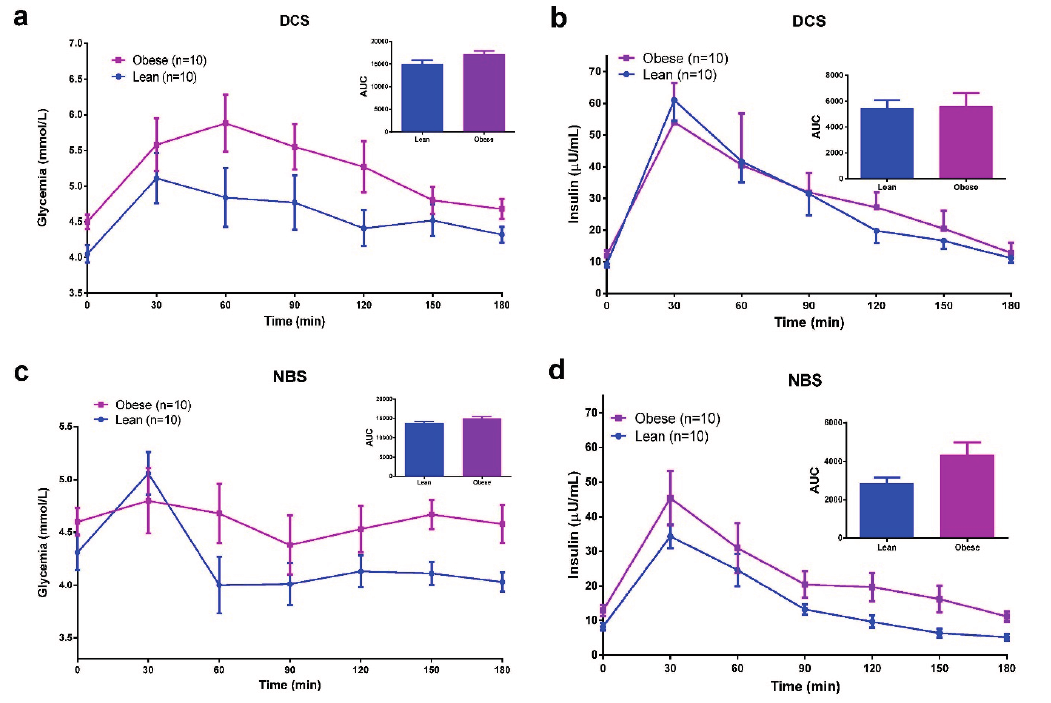
Figure 3. Differences between lean and obese subjects in glycemic and insulin responses during a Meal Tolerance Test (MTT) ( a , b ) Beverage containing digestible corn starch (DCS). ( c , d ) Beverage containing native banana starch (NBS). Notes: Beverages were administered 5 min before the standardized food. Areas under the curve (AUC) were compared using an unpaired Student t test. In ( a ) Obese vs. Lean p = 0.0853; in ( b ) p = 0.8892; in ( c ) p = 0.0749; in ( d ) p =